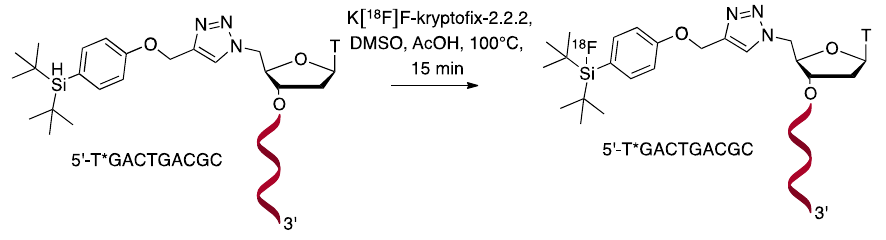
Figure 1. Already functionalized phosphoramidites for 11 C ( left ) or 18 F ( right ) labeling